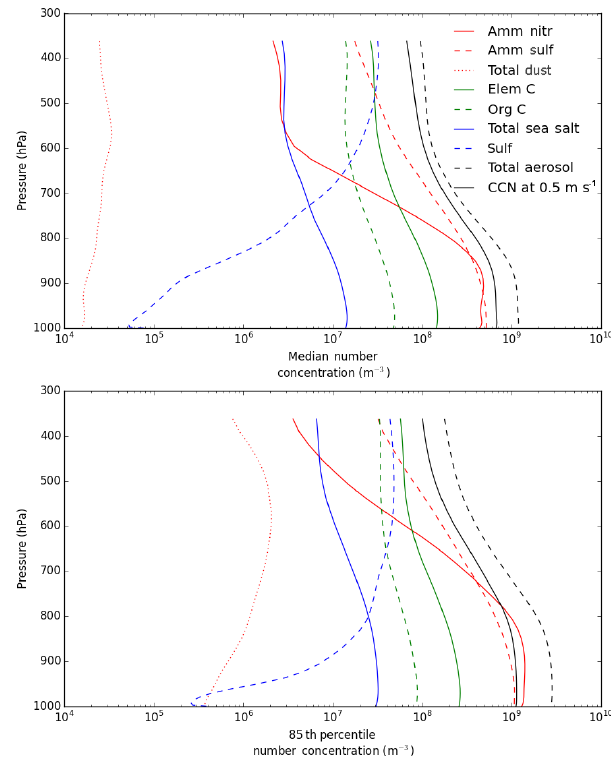
Figure 4. Temporally averaged median (top) and 85th percentile (bottom) number concentration for aerosols and CCN at 0.5ms − 1 from 25 March to 16 June